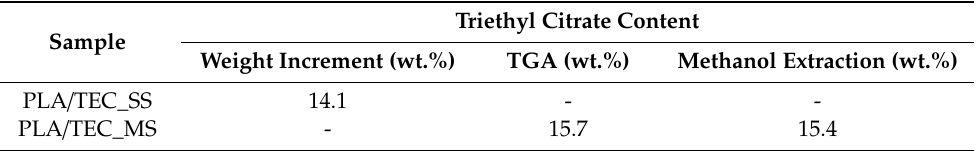
Table 1. Content of triethyl citrate in the polylactide / triethyl citrate (PLA / TEC) systems (solid and molten state modification).